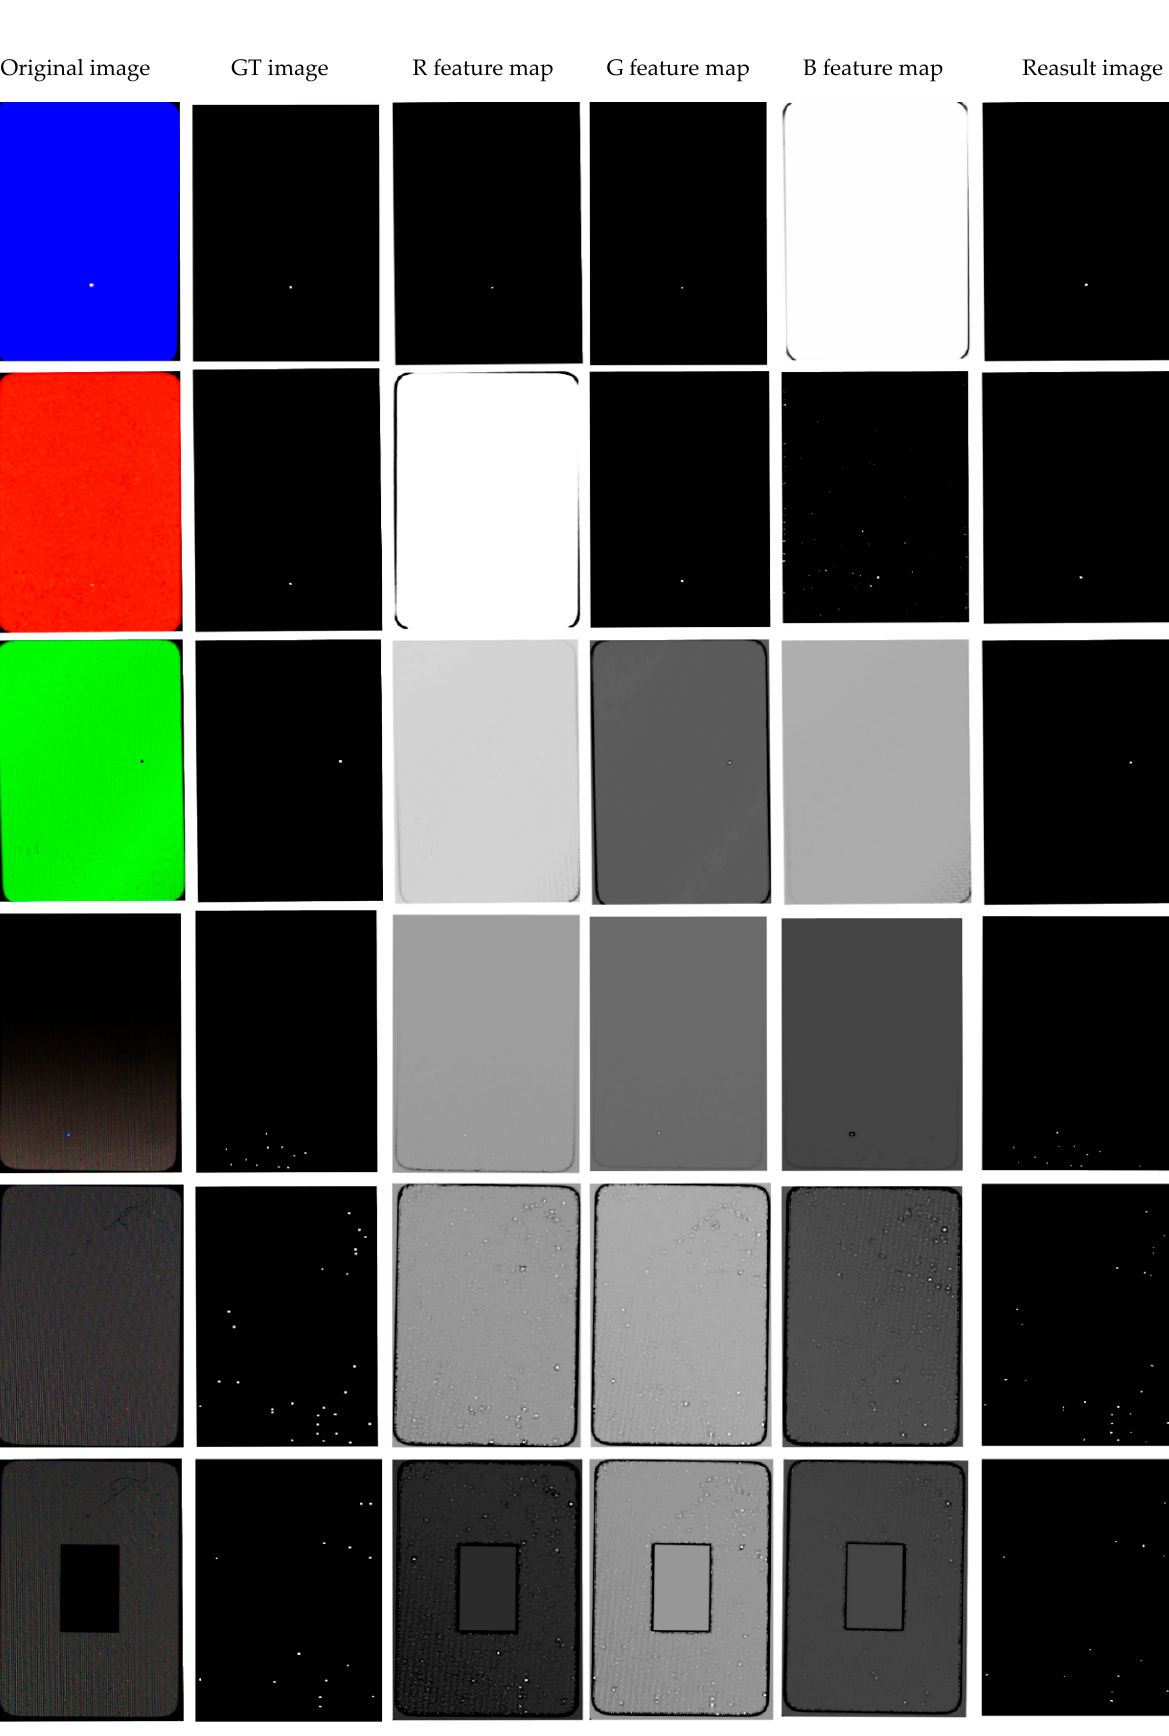
Figure 7. Detection results of our method.